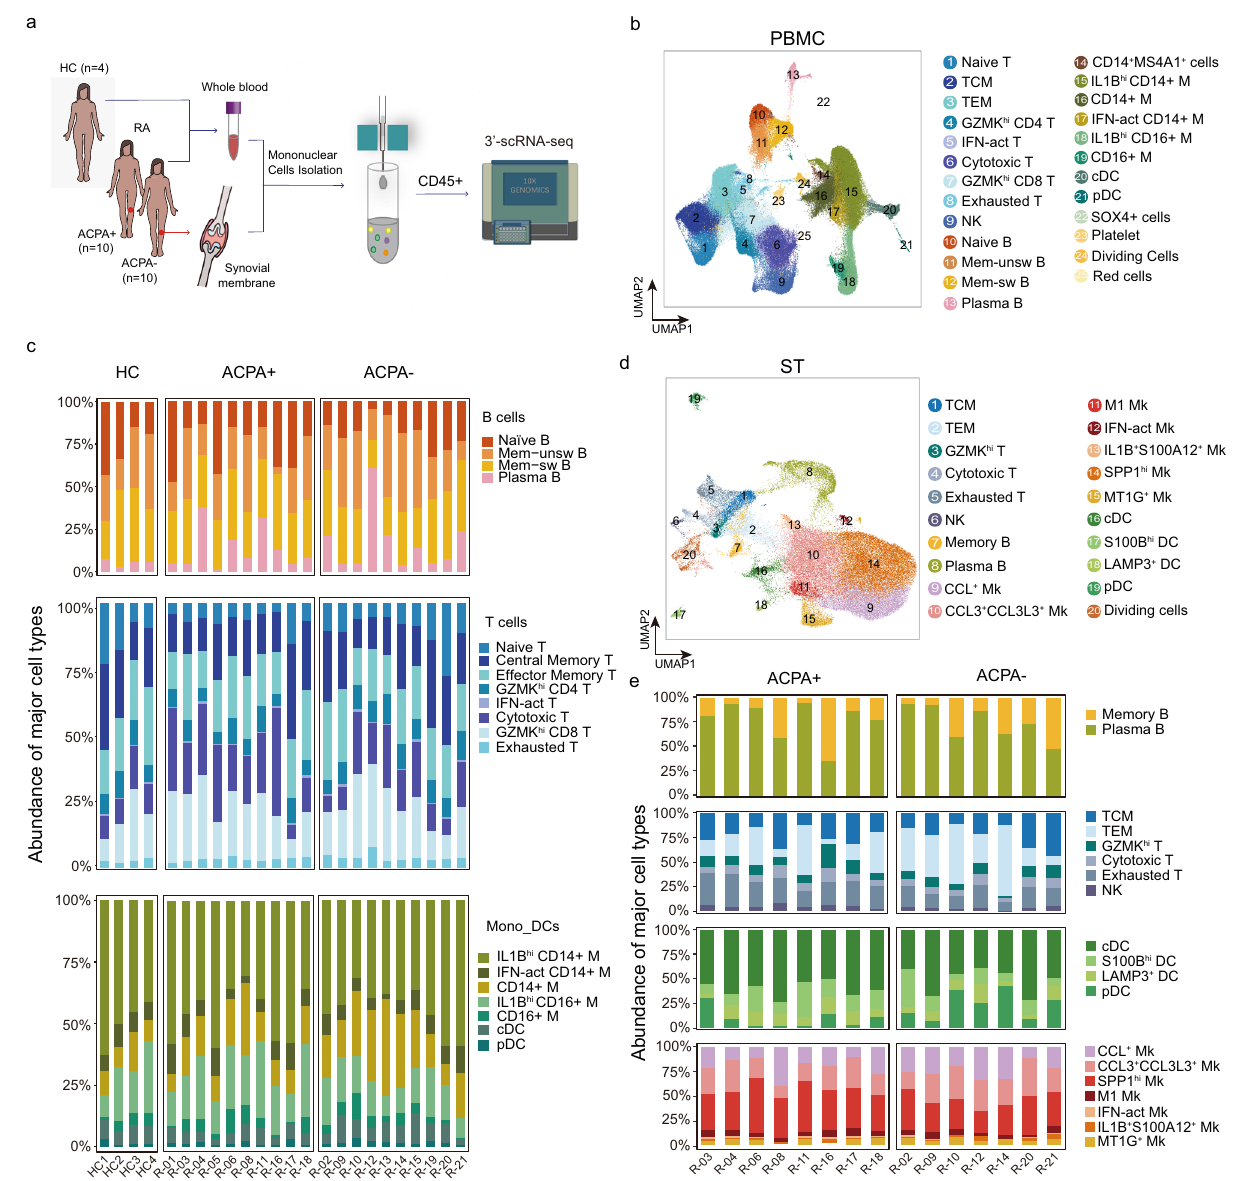
Fig. 1 Clustering and classi fi cation of immune cells in peripheral blood and synovium from patients with RA. a Overview of the experimental work fl ow. HC: Healthy Control; ACPA: anti-citrullinated-peptide antibodies; scRNA-seq: single-cell RNA sequencing. b UMAP visualization of pooled scRNA-seq data of 135,429 CD45 + cells from PBMC (Peripheral blood mononuclear cells). We identi fi ed 25 clusters, including B cells (four clusters), T/NK cells (nine clusters), and myeloid cells (seven clusters). c Relative percentage of cell subtypes in PBMC across donors, grouped by ACPA type. d UMAP visualization of pooled scRNA-seq data of 71,073 CD45 + cells from STMC (synovial tissue mononuclear cells). We identi fi ed 20 clusters, including B cells (two clusters), T cells (6 clusters), dendritic cells (four clusters), and macrophages (seven clusters). e Relative percentage of cell subtypes in STMC across donors, grouped by ACPA three memory B and fi ve plasma cell subtypes in ST, respectively. Among them, HLA-DRB5 + and HLA-DRB5 + HOPX + memory B using Monocle 3. Starting from naïve B cells, we reconstructed a cells, which were absent in more than half (four of seven) of STs trajectory with three branches in PBMCs. We noted that although from ACPA- RA patients, shared common highly expressed genes HLA-DRB5 + Plasma B subsets expressed plasma B-related genes ( GPR183 and HLA-DRB5 ) and distinct HOPX expression in ( MZB1 ), they are enriched for “ peptide antigen binding ” and HLA-DRB5 + HOPX + memory B cells (Fig. 2d – f, Supplementary “ antigen processing and presentation, ” which resemble an Fig. 3b). CCL + memory B cells, which express a set of chemokine “ intermediate ” subset (Fig. 3a). In HCs, progression proceeded genes that include CCL3 , CCL13 , and CCL18 , were enriched in the synovial tissues (Fig. 2d – e). Relatively higher proportions of from naïve B cells to either HLA-DRB5 + Plasma B cells and then to plasma cells or along the trajectory from Mem-unsw B to CCL + memory B cells were observed in the synovial membrane of Mem-sw B (Fig. 3b). In contrast, in PBMCs of RA patients, we ACPA- RA patients but this difference was not statistically sig- identi fi ed an alternative pathway from naïve B cells to IGHG4 + ni fi cant from that in ACPA + RA patients (Fig. 2f).